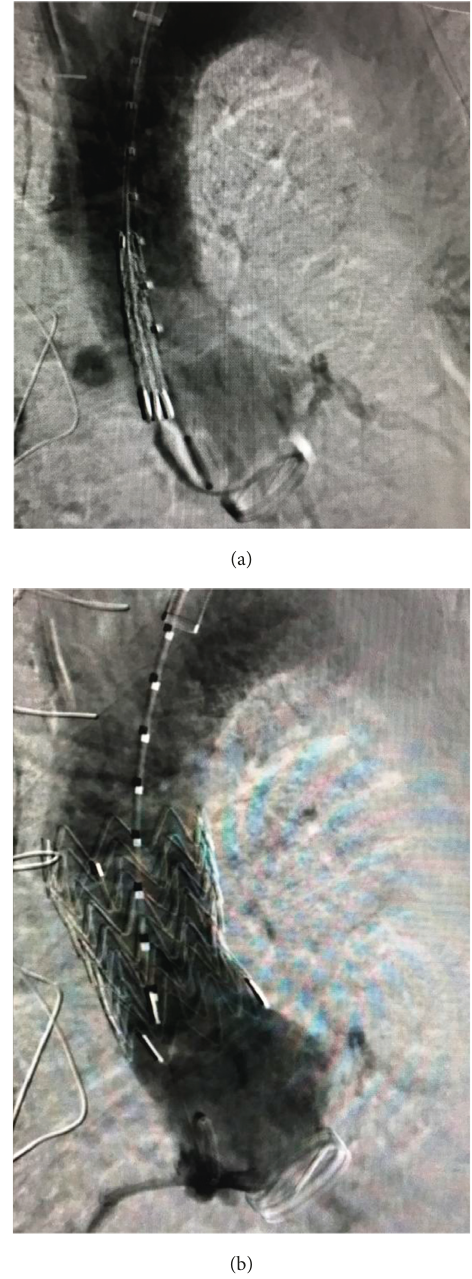
Figure 3: Aortic root angiogram showing placement of graft and postdeployment with cessation of fistulous